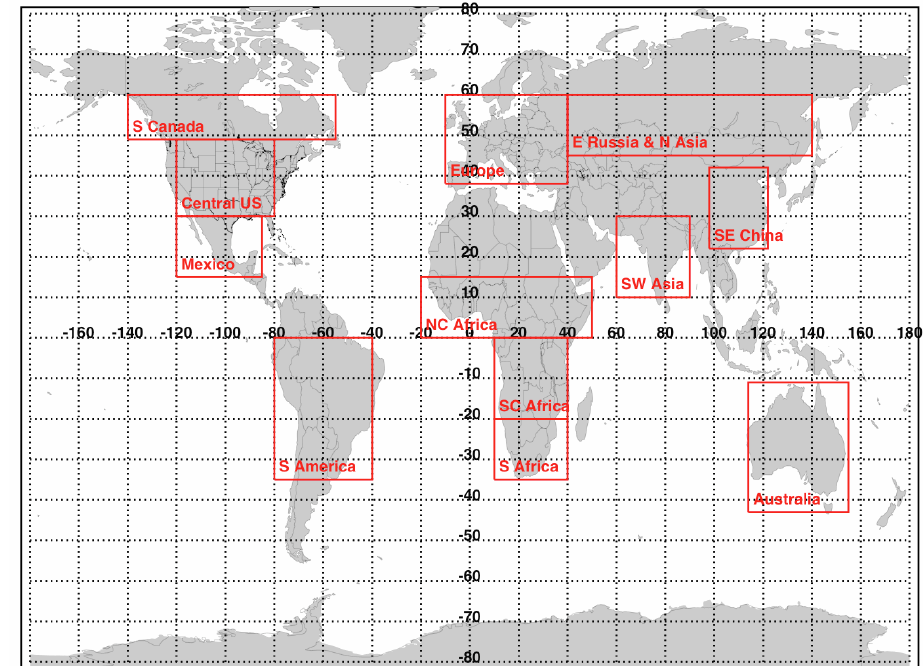
Fig. 12. Regions employed for the seasonal analyses in Figs. 13 and Figure 12: Regions employed for the seasonal analyses in Figures 13 and 14. 2